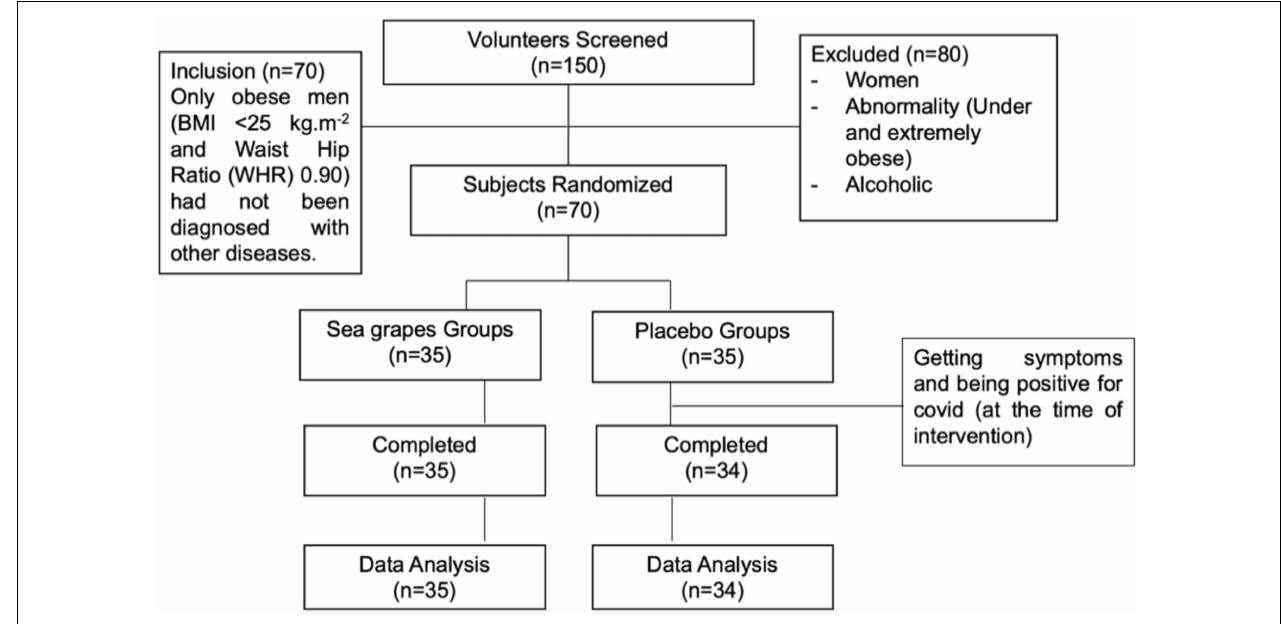
FIGURE 2 | CONSORT diagram showing the flow of the study subject through the 4-week